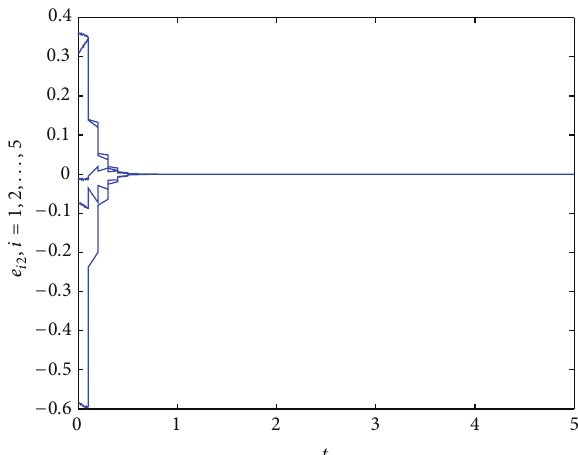
Figure 2: Time evolution of synchronization errors 𝑒 𝑖2 (𝑡), (𝑖 = 1, 2, .. ., 5) of the asymmetric coupled network (21) with random initial values.